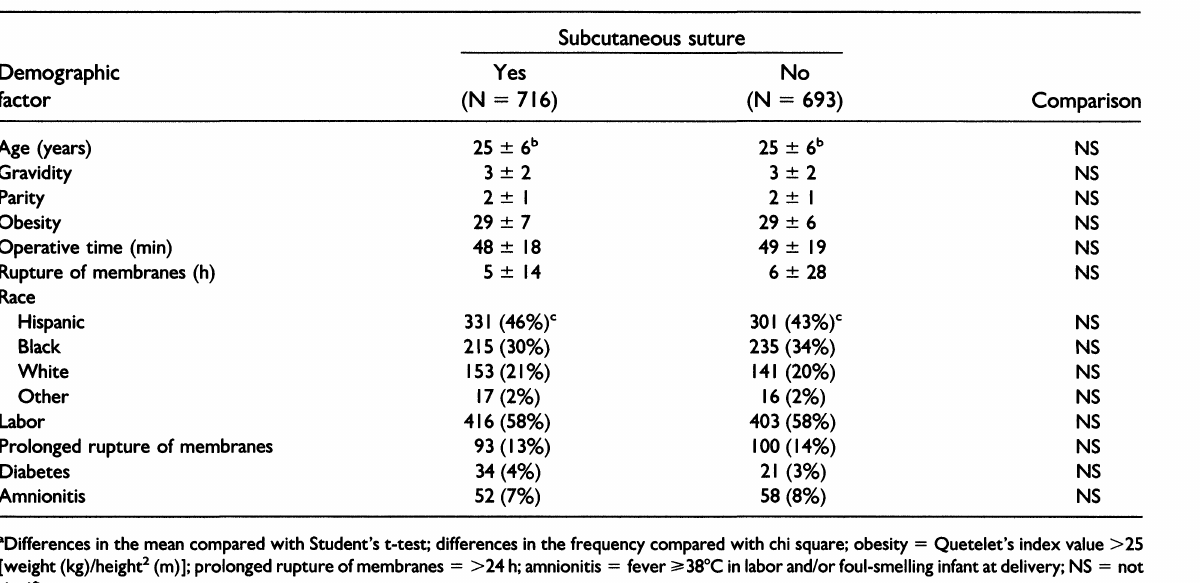
TABLE 2. Pregnancy outcomes in 1,409 women with and without subcutaneous sutures at cesarean section